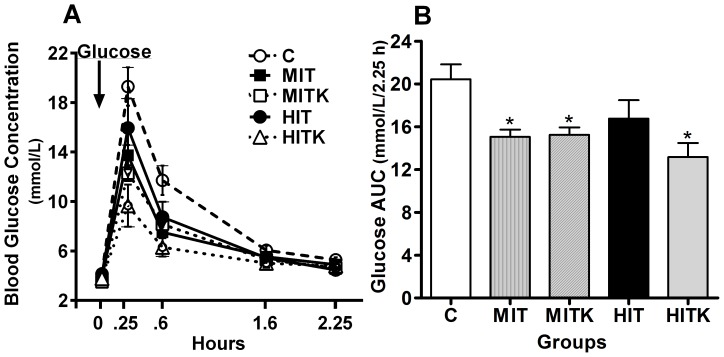
Glucose tolerance test in all experimental groups.All rats received i.p. injections of D-glucose (200 mg/100 g body weight) at the 0 time point. A) Glucose concentrations in mmol/L. B) Glucose concentrations from (A), expressed as area under the curve (AUC) in % basal during a 2.25-h period. Values are means ± S.E. from 6 independent samples; *p<0.05, ANOVA and Tukey's tests.